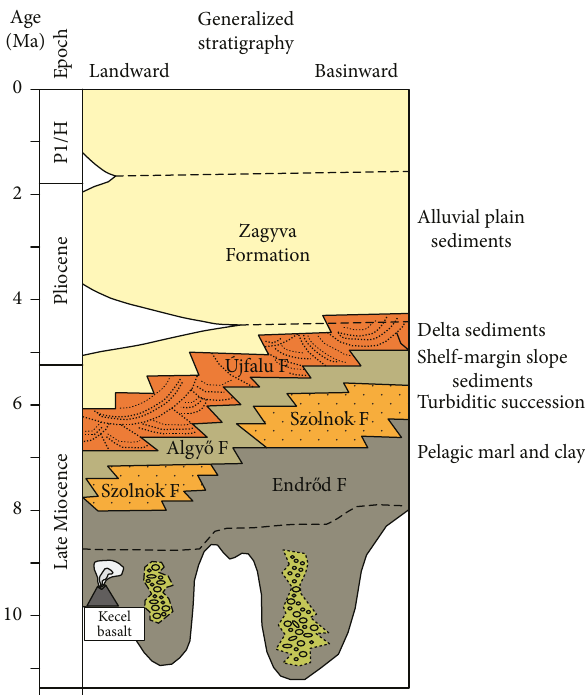
Figure 4: Chrono- and lithostratigraphy of the Miocene – Holocene deposits in the study area simpli fi ed after Sztanó et al. [29]. Abbreviations: Pl=Pleistocene;